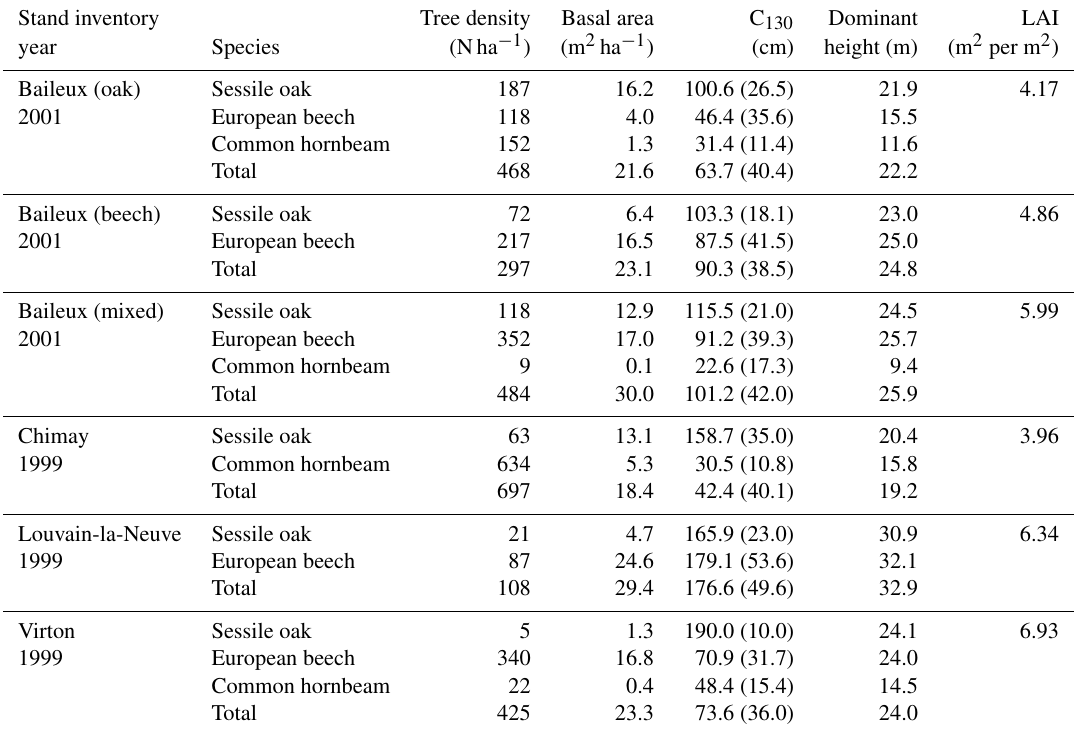
Table 2. Initial stand characteristics for the main tree species and for the whole stands. Stand inventory